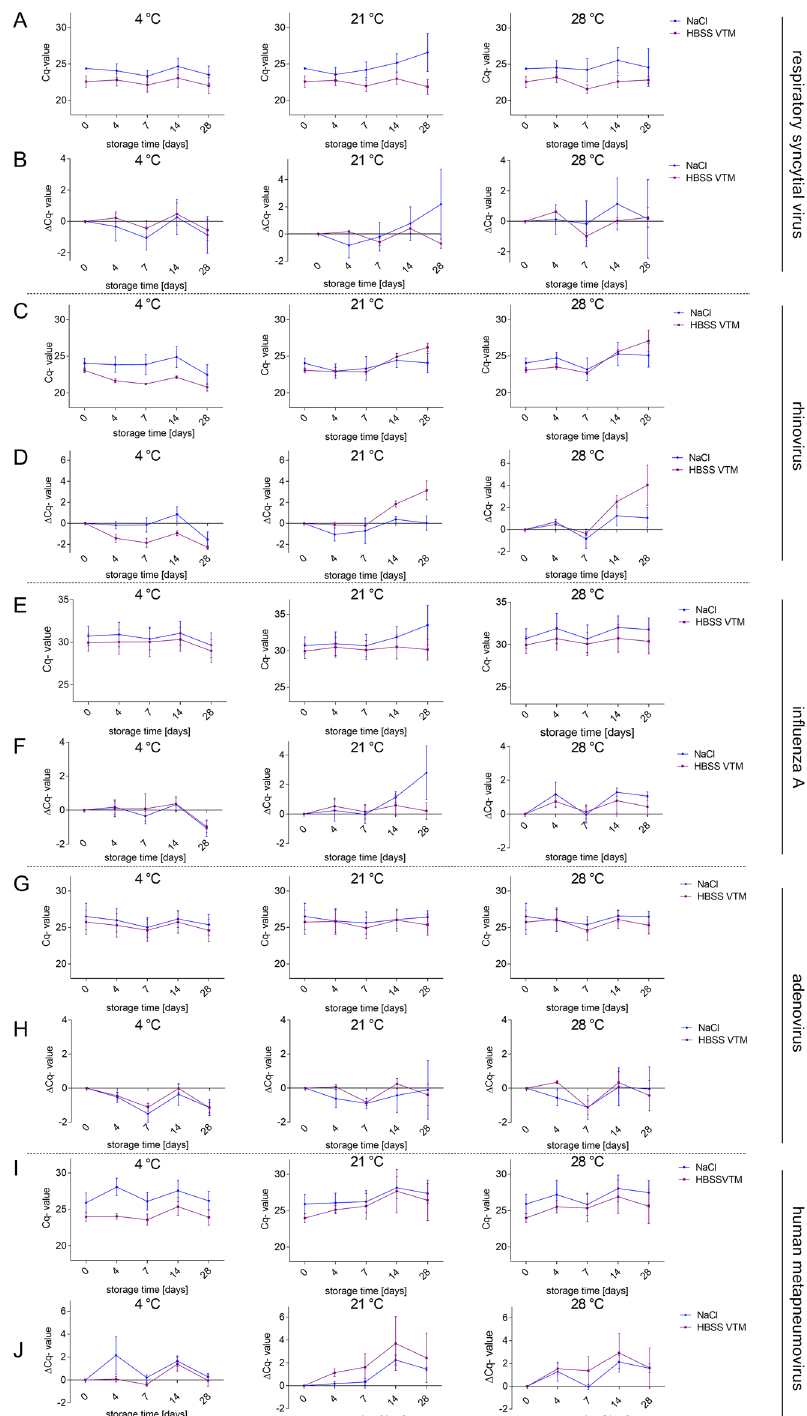
Figure 4. HBSS VTM and saline are both suitable transport media for respiratory virus specimens at storage temperatures up to 28 °C. RT-PCR measurements of clinical specimens positive for, respiratory syncytial virus ( A , B ), rhinovirus ( C , D ), influenza A ( E , F ), adenovirus ( G , H ) and human metapneumovirus ( I , J ) stored in NaCl (blue point) or HBSS VTM medium (purple rectangle) over 4 weeks at 3 different temperatures (4 °C, 21 °C and 28 °C). n = 3 for each group are shown. * p -values < 0.05, repeated measurement